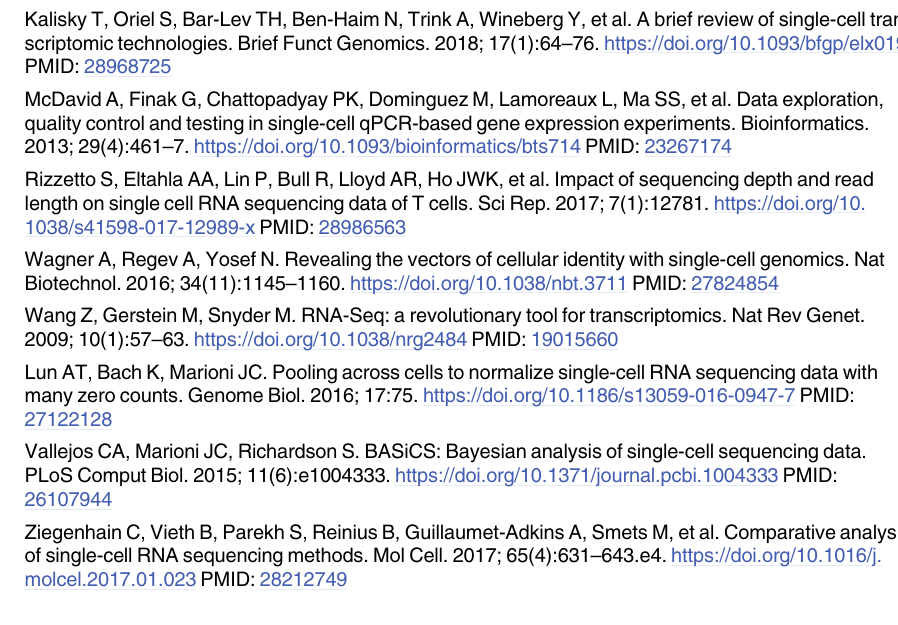
S9 Table. Enriched GO terms (p < 10 − 3 ) detected in the up-regulated genes of H1 cells in SIMPLE imputed data. S10 Table. Enriched GO terms (p < 10 − 3 ) detected in the up-regulated genes of H1 cells in PBLR imputed